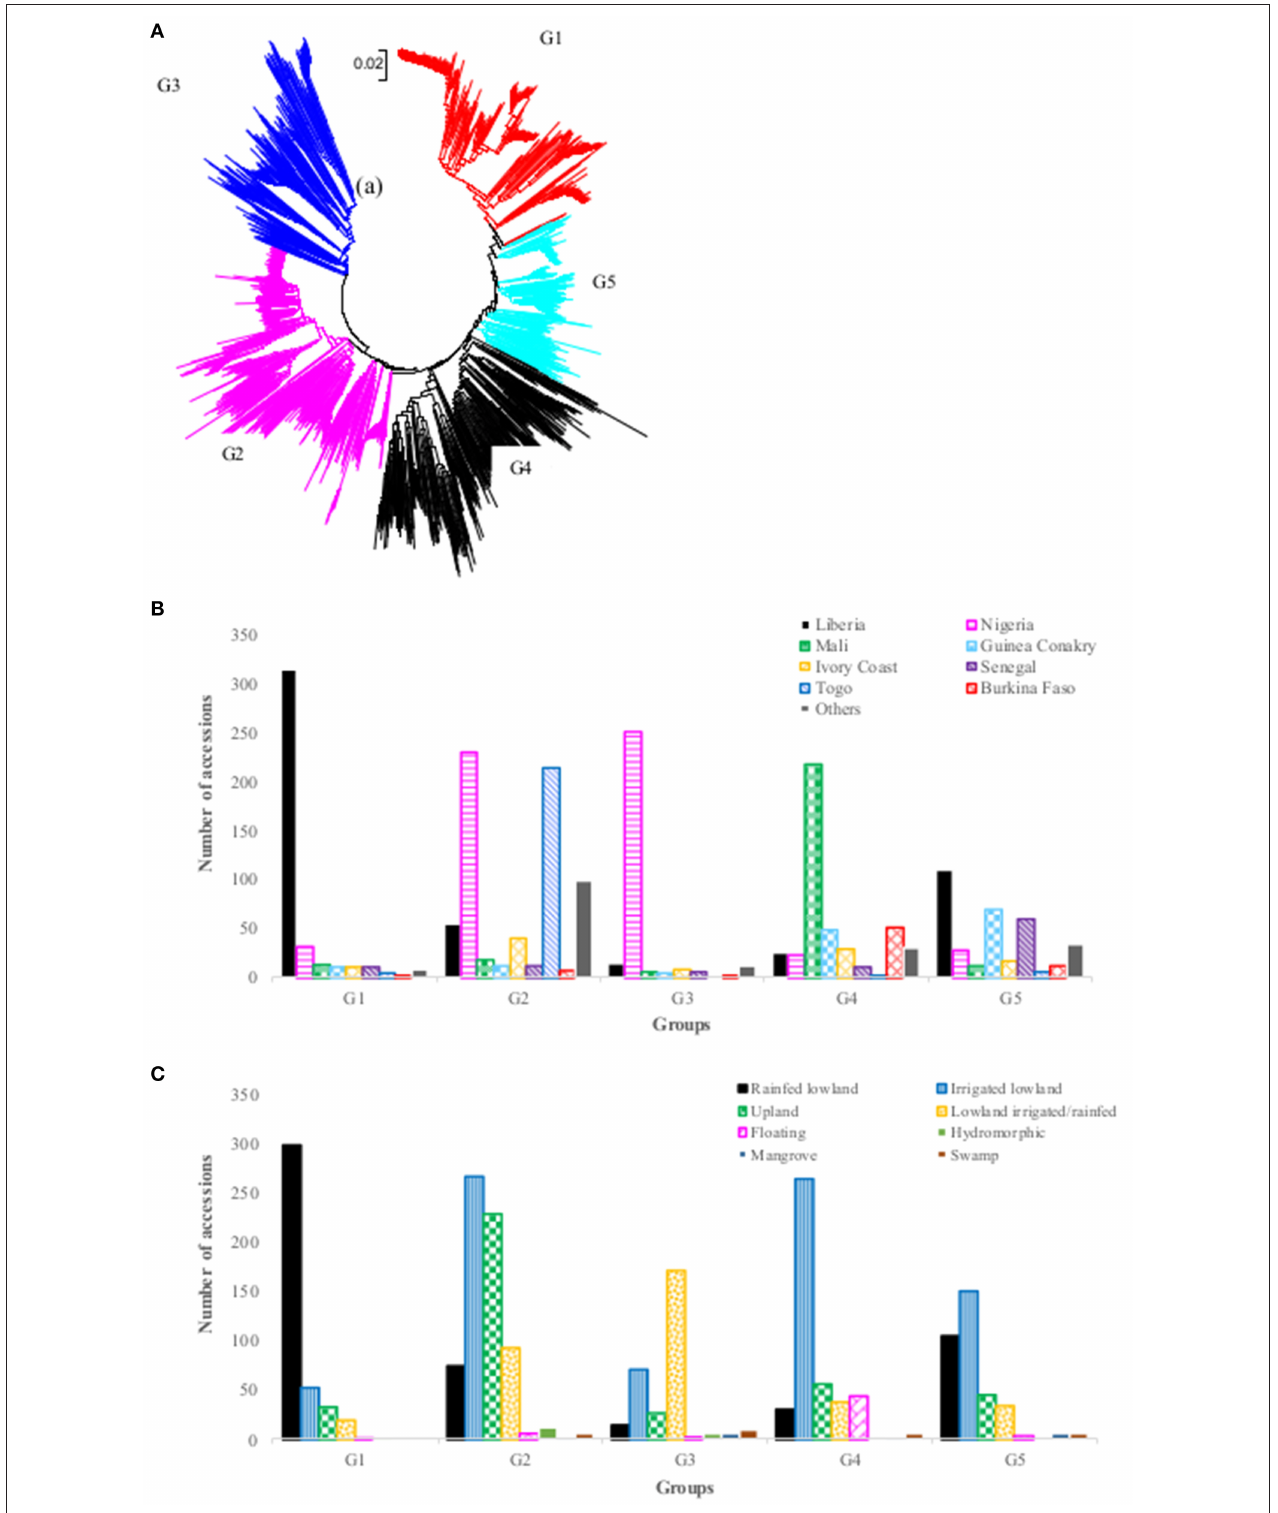
FIGURE 2 | (A) Neighbor-joining tree of 2,179 Oryza glaberrima accessions based on 3,834 polymorphic SNPs (G1 = Group 1, red font; G2 = Group 2, pink font; G3 = Group 3, blue font; G4 = Group 4, black font; G5 = Group 5, aqua font); (B) summary of accessions in each group by country of origin (only countries with > 40 accessions were listed here); (C) summary of accessions belonging to each group by ecology. See Supplementary Table S1 for detail group membership.